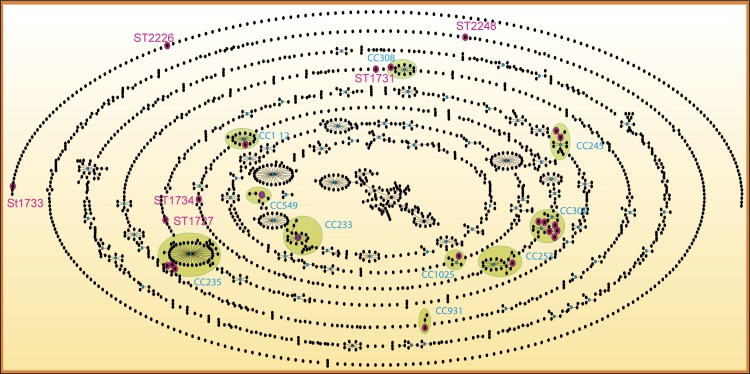
Network of the 2266 sequence types listed in the Pseudomonas aeruginosa PubMLST database (April 2016).P. aeruginosa isolates (n = 59 STs). Black points represent sequence types (STs); lines connect single-locus variants (SLVs). The STs with pink halos were described in this study. Blue points represent founder STs, and the clonal complexes (CC) formed are highlighted in green. The strict definition of group was used (6/7 shared alleles).